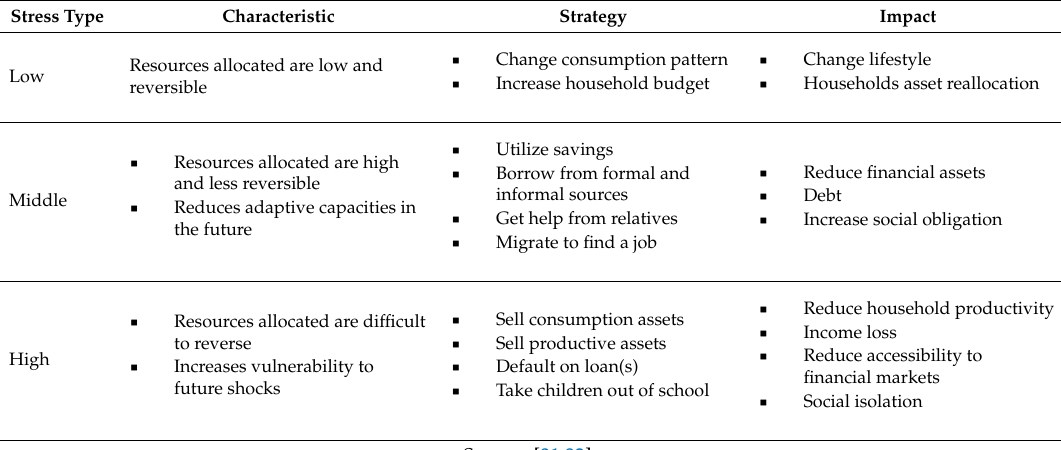
Table 1. Types of ex post coping strategy based on stress